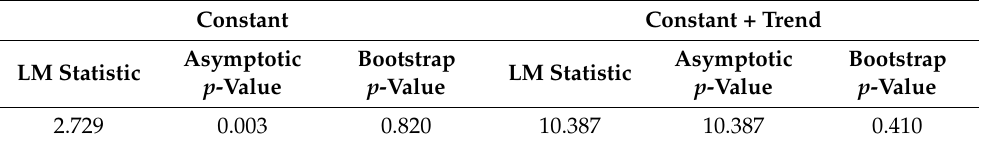
Table 4. Westerlund and Edgerton’s [54] Bootstrap cointegration test results.